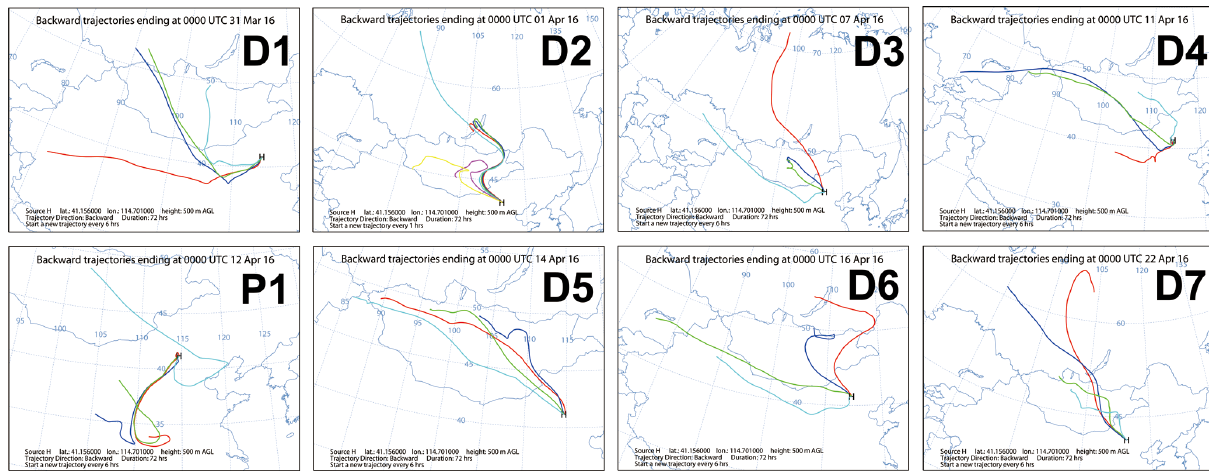
Figure 4. The 72h back trajectories of air masses in Zhangbei calculated using the HYSPLIT model. D1–D7 represent the dust events that occurred in Erenhot.